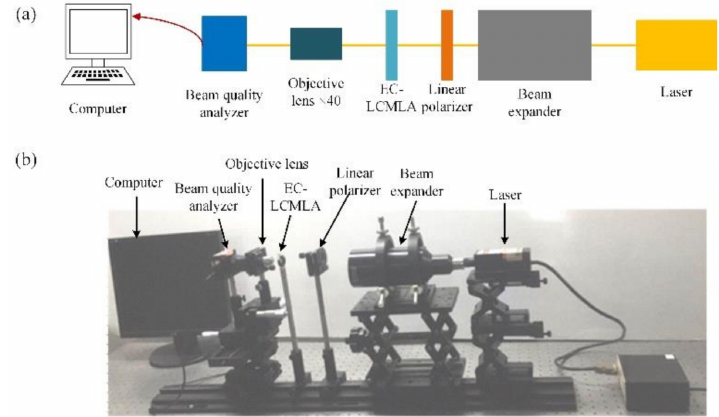
Figure 6. Optical measurement system for characterizing the proposed EC-LCMLA. ( a ) Measurement schematic diagram. ( b ) Actual testing platform.